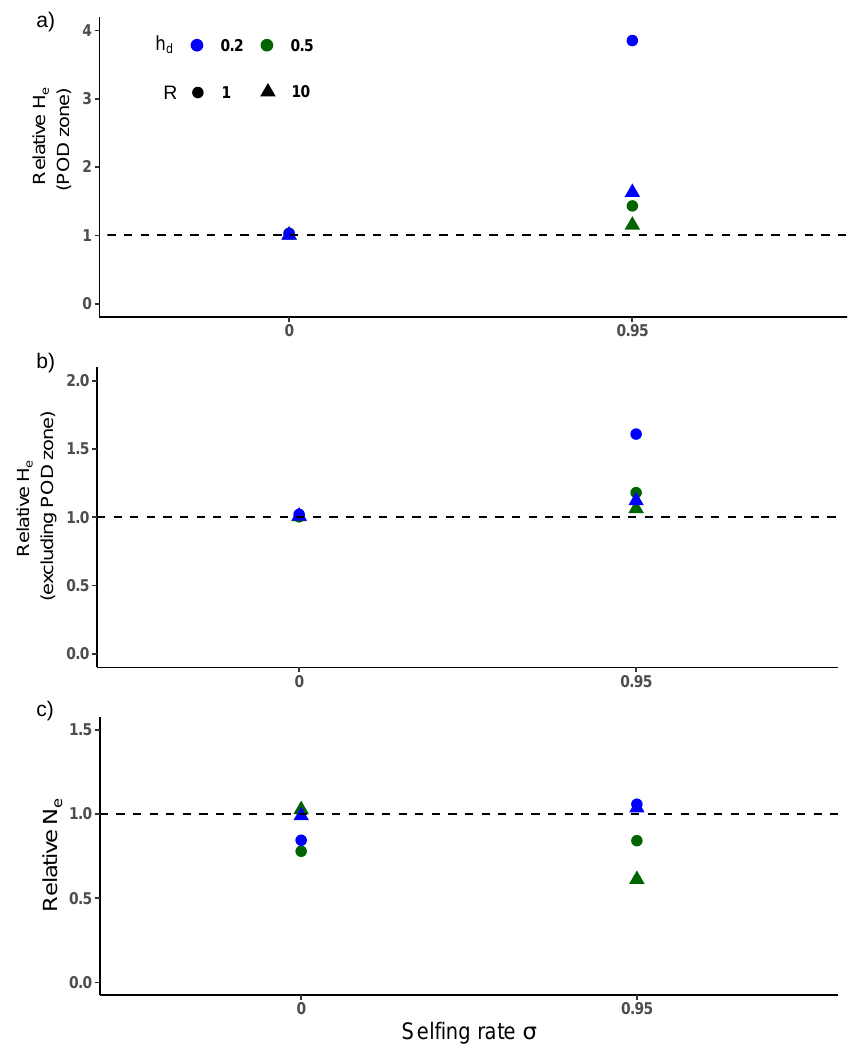
Figure S7 – Associative-Overdominance of background mutations affects selection dy- namics within POD zones and vice versa. Graphs compare the effect of recessive ( h d = 0.2 blue) to codominant ( h d = 0.5 green) background mutations on population heterozy- gosity as a function of the selfing rate. a) Heterozygosity, H e , within a POD zone with background mutations occurring elsewhere in the genome relative to H e in a popula- tion lacking background mutations. b) H e outside the POD zone in a population with a POD zone relative to one without. c) N e in a population with POD selection relative to one without. The background mutation rate U = 0.5 and the map lengths simulated are R = 1 and 10 Morgans. These simulations use 100 POD load loci ( n L = 100 ) randomly 6 placed within the POD zone over a map length of ℓ = 10 − Morgans. Selection coeffi- cients within the POD zone are s = 0.01 with dominance h = 0.2 and population size N = 1000